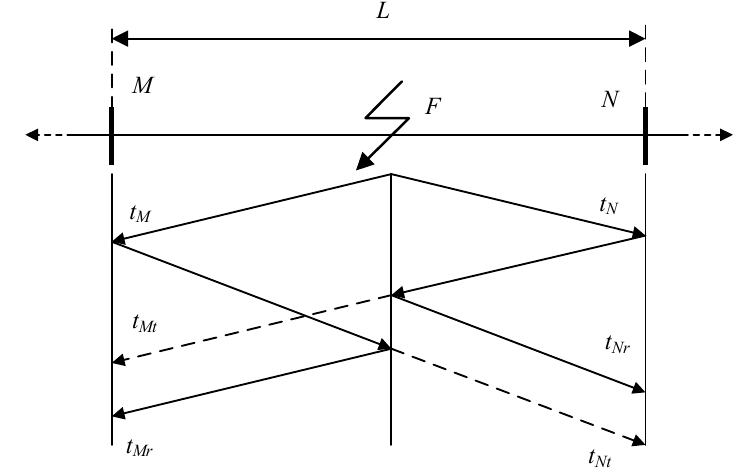
Figure 1. The schematic diagram of the traveling wave process.